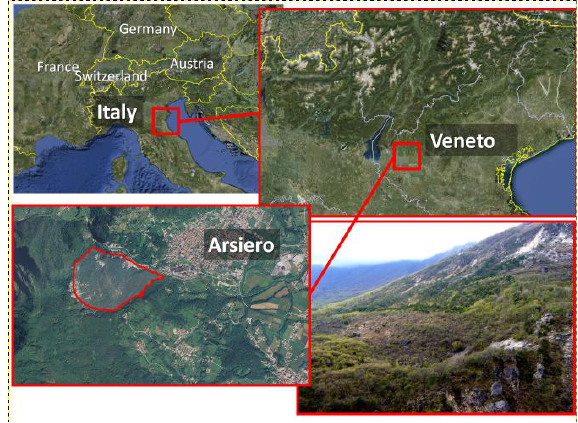
Figure 1. Multi-scale views of the study area.